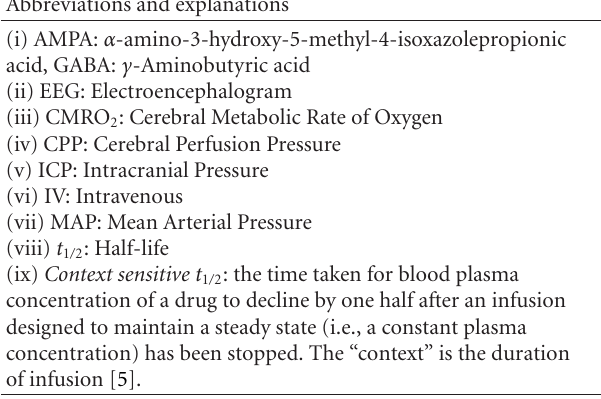
Abbreviations and